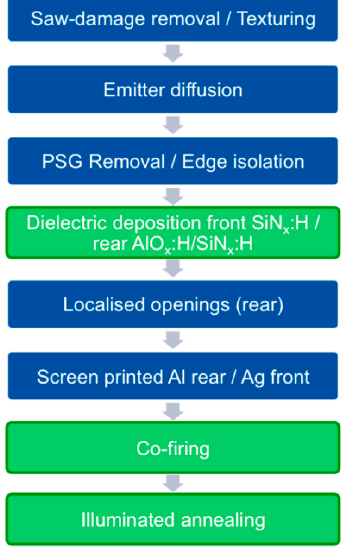
Figure 3. The process flow for the fabrication of industrial screen-printed PERC solar cells with a rear surface passivation dielectric stack of plasma-enhanced chemical vapour deposited (PECVD) hydrogenated aluminium oxide (AlO x :H) and silicon nitride (SiN x :H). Processes related to the hydrogenation of B-O defects are shown in green. Other processes are shown in blue.